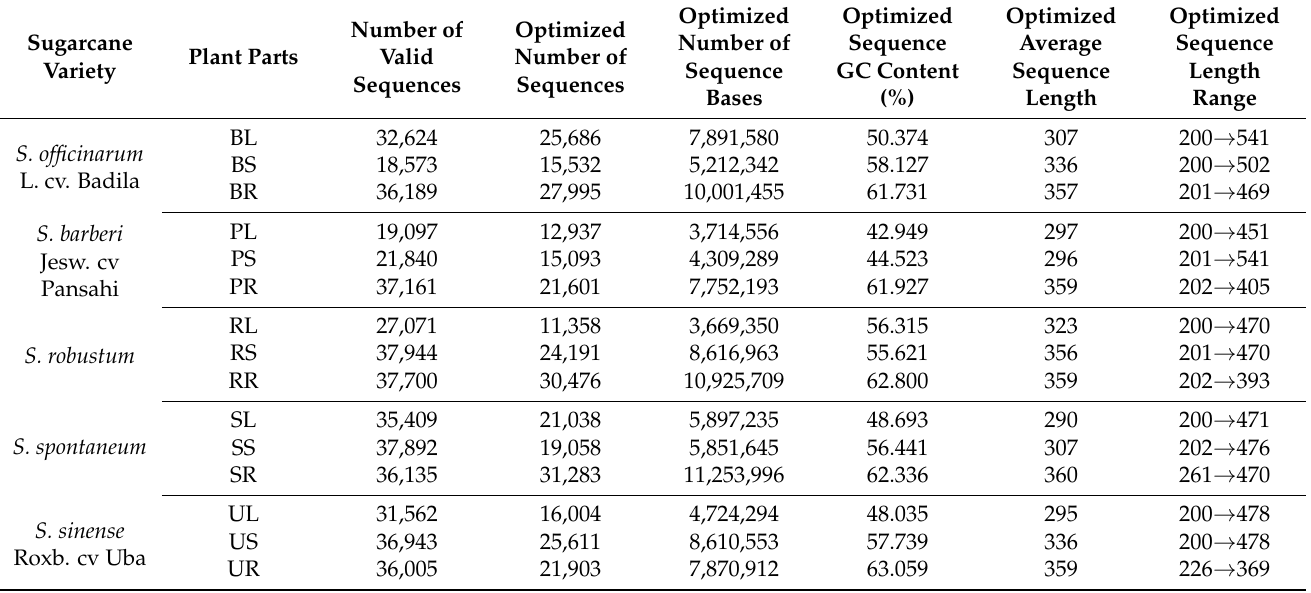
Table 2. Optimized sequence data used for subsequent clustering operational taxonomic units and species information